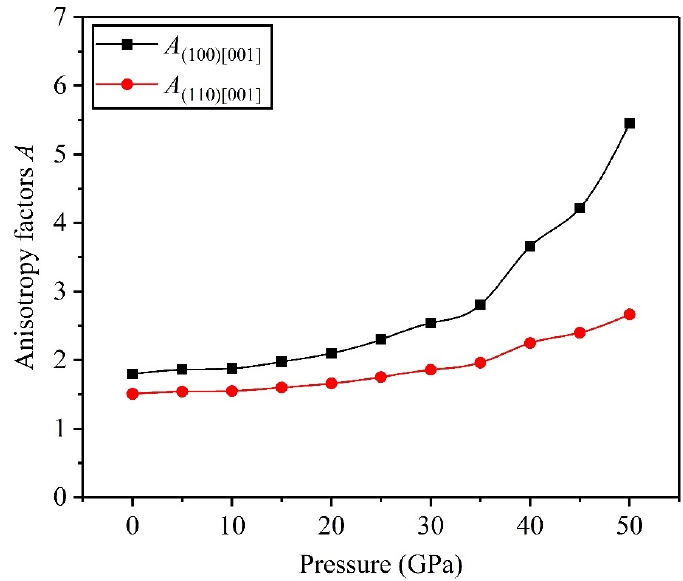
Figure 7. Variation curves of anisotropy factors under different pressures for the NiTi SMA.